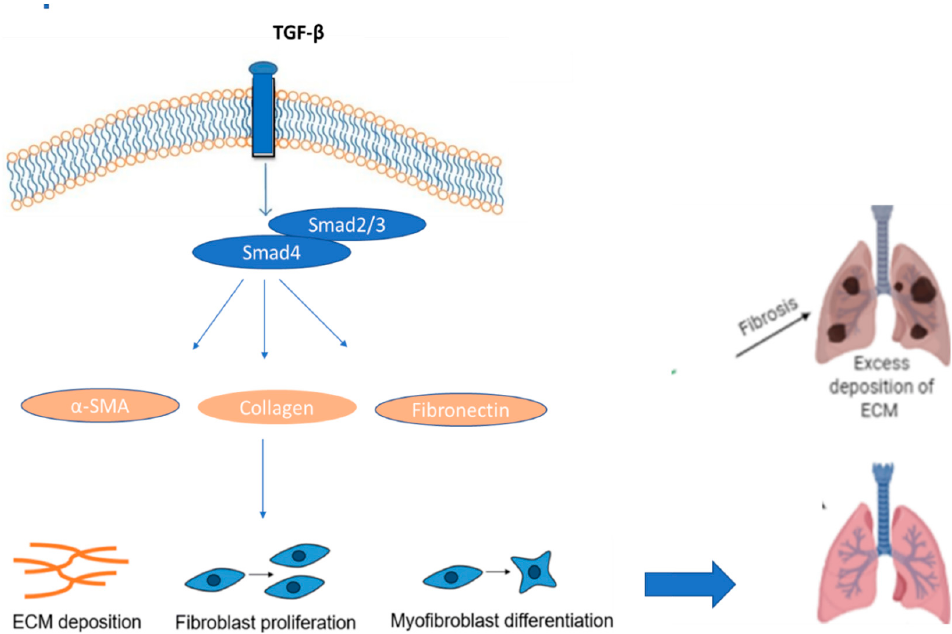
Figure 15. The function of TGF- β in inducing pulmonary fibrosis.